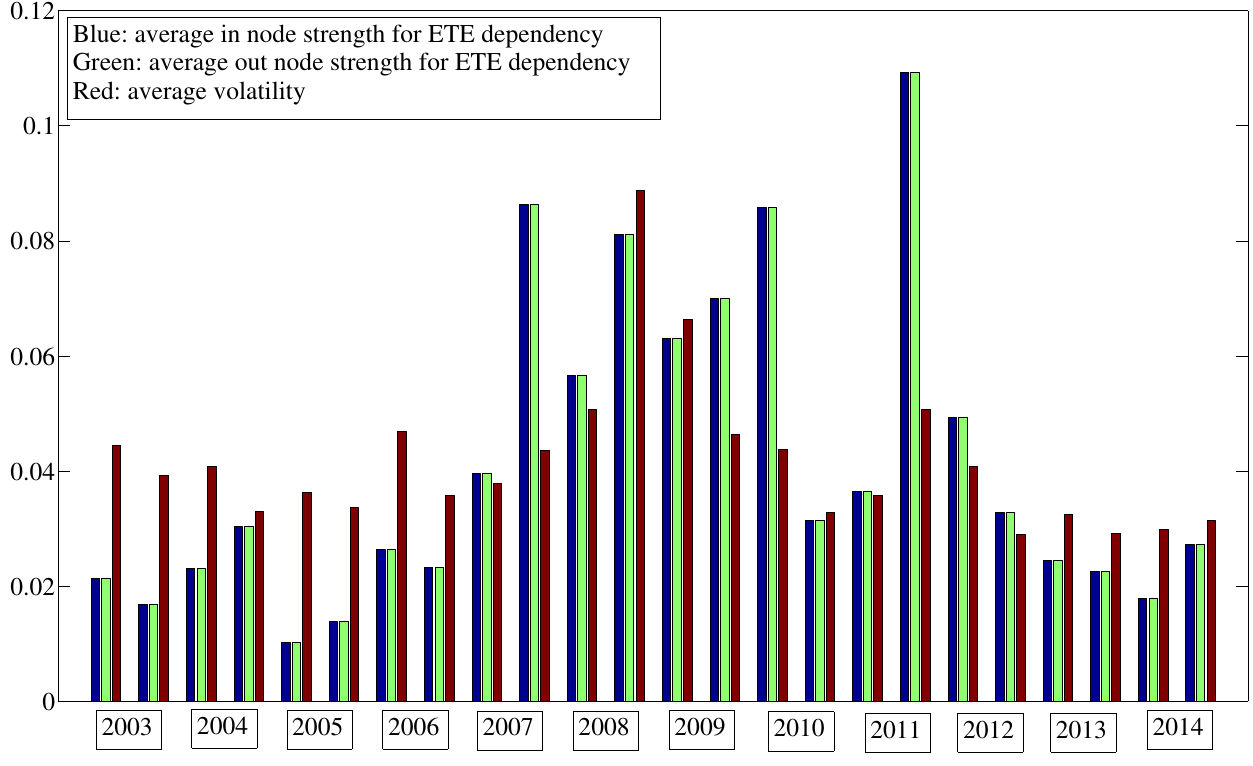
Figure 17. Average ETE dependency × average